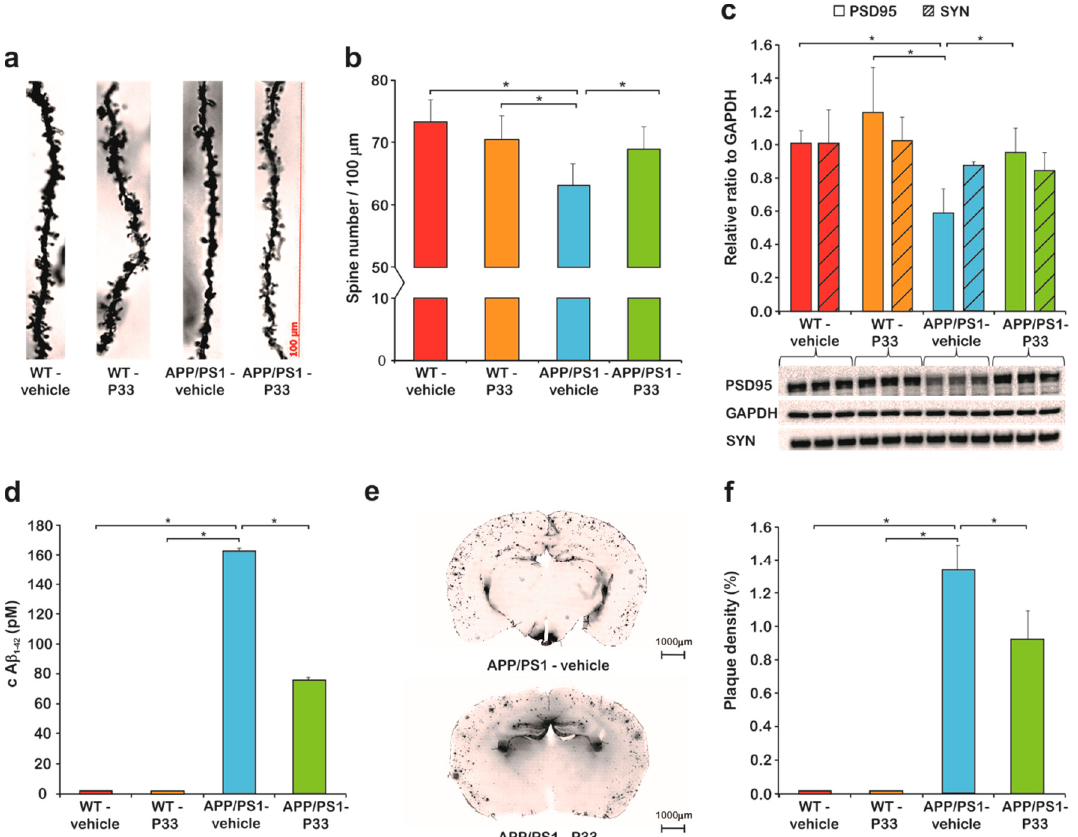
Figure 5. Histology results I. ( a ) The apical dendritic spine density in the CA1 region of the hippocampus (HC) was monitored. Representative photomicrographs of oblique dendritic segments stemming from WT-vehicle, WT-P33, APP / PS1-vehicle, and APP / PS1-P33 mice (100 × magnification; scale bar: 100 µ m). ( b ) Golgi staining revealed changes in the spine density after P33-treatment. Quantitative analysis of the apical dendritic spine density proved that P33 protected the synaptic terminals ( p = 0.015). An impaired density was measured in APP / PS1-vehicle mice compared to WT-vehicle ( p = 0.002), WT-P33 ( p = 0.019), and APP / PS1-P33 ( p = 0.041) animals. Bars represent the mean + standard error of